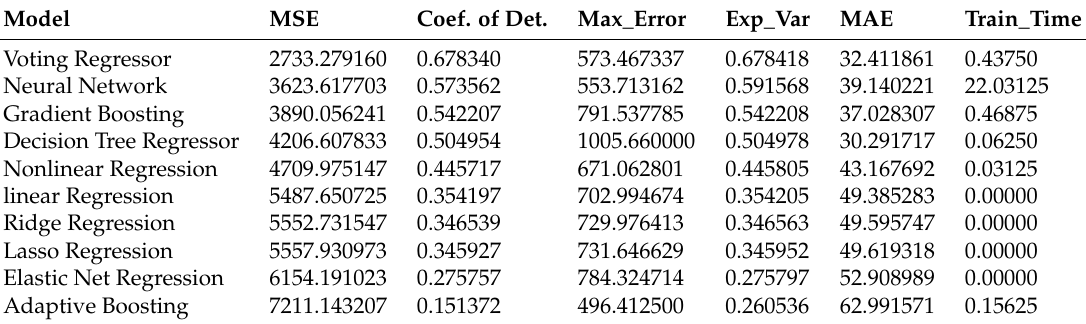
Table 5. Quality metrics of different regression